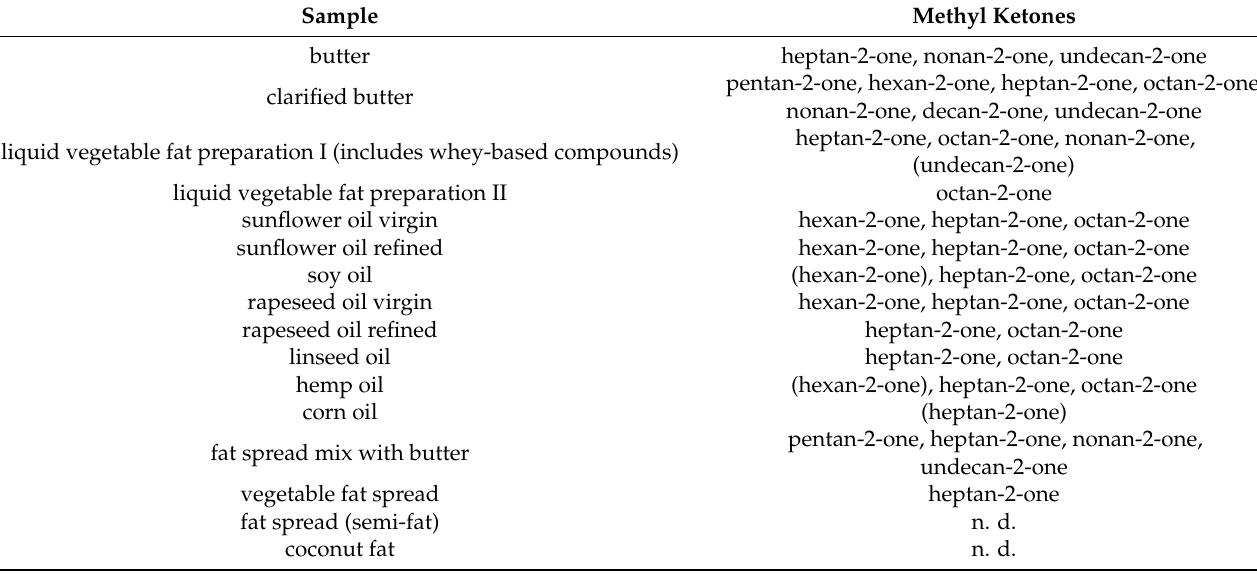
Table 1. Detected methyl ketones in milk fat and vegetable oils, heated at 160 ◦ C 20 min; n. d. = not detected; substances in brackets were only detected with very low areas.